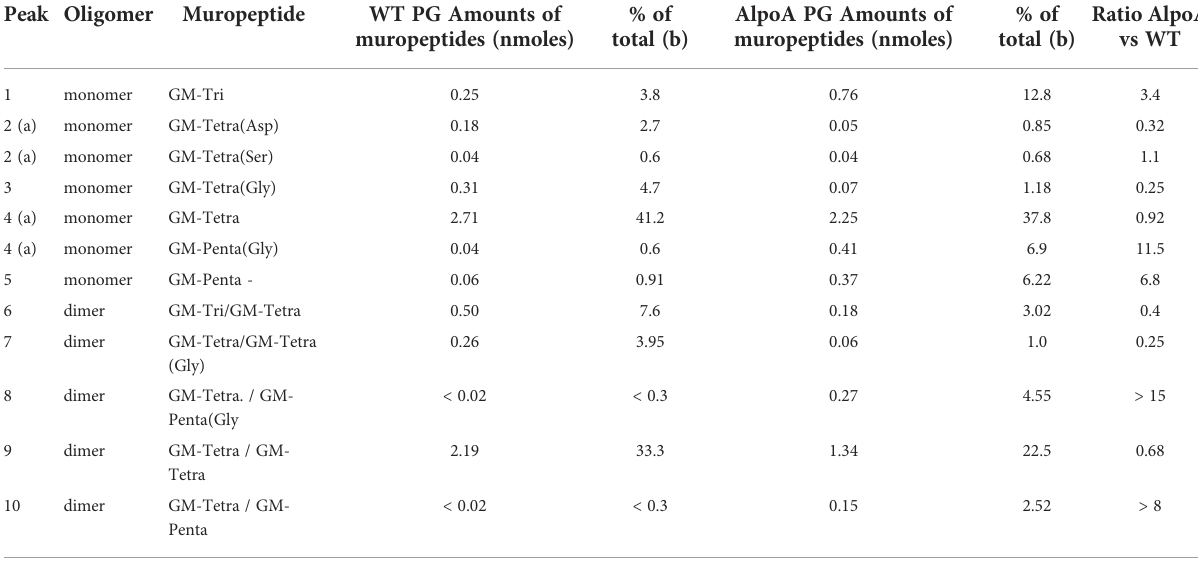
TABLE 2 Pattern of muropeptides identi fi ed by HPLC in H. in fl uenzae 3655 wt and isogenic D lpoA. Peak